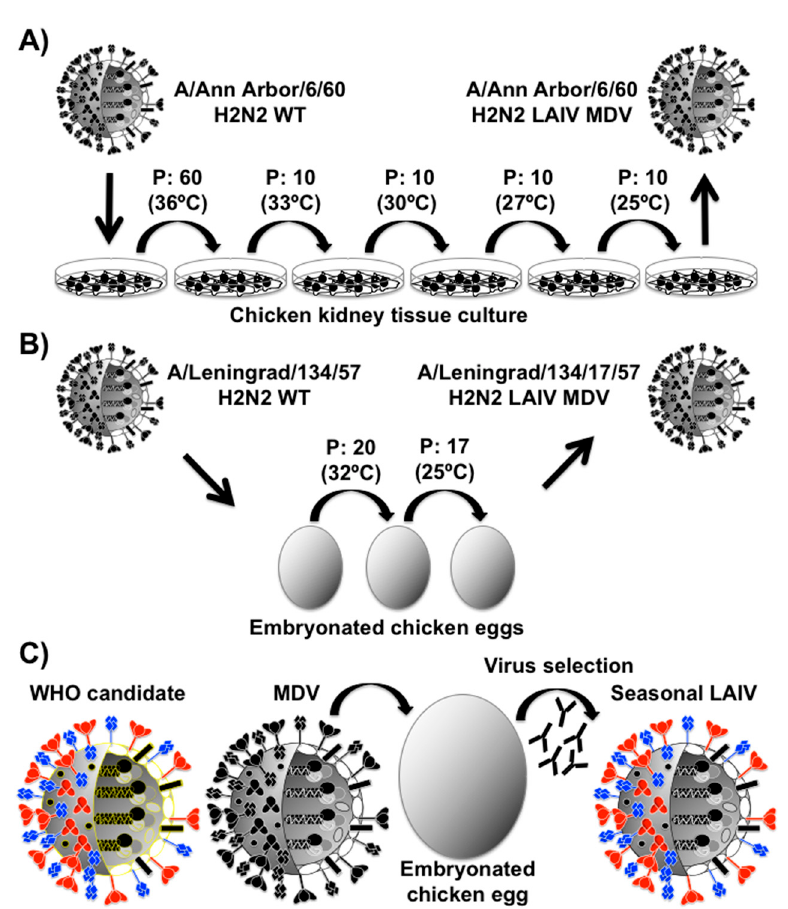
Figure 4. Generation of LAIV: ( A ) Isolation of the A/Ann Arbor/6/60 H2N2 LAIV MDV: A/Ann Arbor/6/60 H2N2 wild-type (WT) was serially passage 100 times (P1 to P100) in chicken kidney tissue culture (CKTC) cells under gradually reduced temperatures (36 °C to 24 °C). The obtained A/Ann Arbor/6/60 LAIV contained several mutations and the ones responsible for the att, ca, and ts has been mapped to a single residue in PB2 (N265S), three residues in PB1 (K391E, E581G, and A661T) and a single residue (D34G) in NP (Figure 2). The A/Ann Arbor/6/60 H2N2 LAIV is used as master donor virus (MDV) to produce the seasonal LAIV. ( B ) Generation of the A/Leningrad/134/17/57 H2N2 LAIV MDV: A/Leningrad/134/17/57 H2N2 WT was serially passage 20 times (P1 to P20) in embryonated chicken eggs at optimal temperature of 32 °C. Then, the A/Leningrad/134/17/57 H2N2 LAIV MDV was obtained after 17 additional passages at 25 °C. ( C ) Schematic representation to produce the seasonal LAIV: The traditional method for generating reassortant virus is based on the co-infection with two influenza viruses in eggs. Both the WHO candidate IAV (left) and the A/Ann Arbor/6/60 H2N2 LAIV MDV (right) are inoculated in eggs followed by the selection of appropriate seed viruses by amplification in the presence of antibodies against the HA and NA of A/Ann Arbor/6/60 H2N2. The resulting virus containing the HA (red) and NA (blue) segments from the WHO-recommended IAV strain and the six inteRNAl vRNAs of the MDV A/Ann Arbor/6/60 H2N2 LAIV is amplified and used for vaccine production and used as a seasonal LAIV. Current seasonal LAIV can be generated either by classical reassortment in embryonated chicken eggs or by the newly developed plasmid-based reverse genetic techniques [38,125]. These contain the six inteRNAl genes (PB2, PB1, PA, NP, M, and NS) from the original ts, ca, att master donor virus (MDV) A/Ann Arbor/6/60 H2N2 and the two viral glycoproteins (HA and NA) from predicted circulating seasonal IAV (Figure